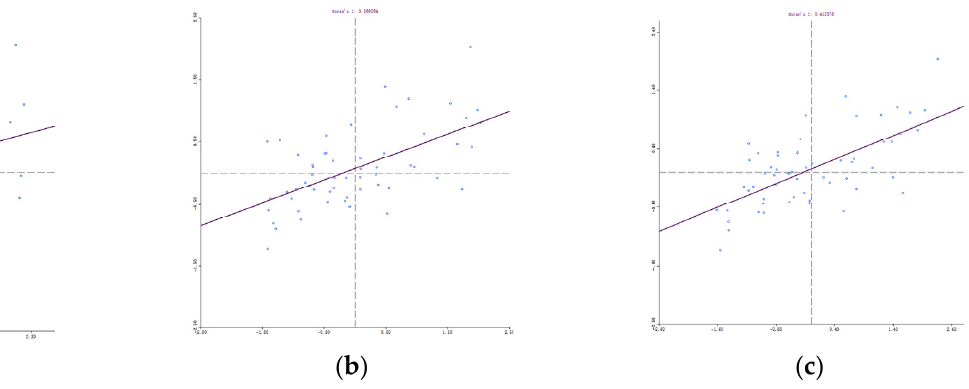
Table 1. Descriptive statistics of the overall level of rural tourism land in the study area.